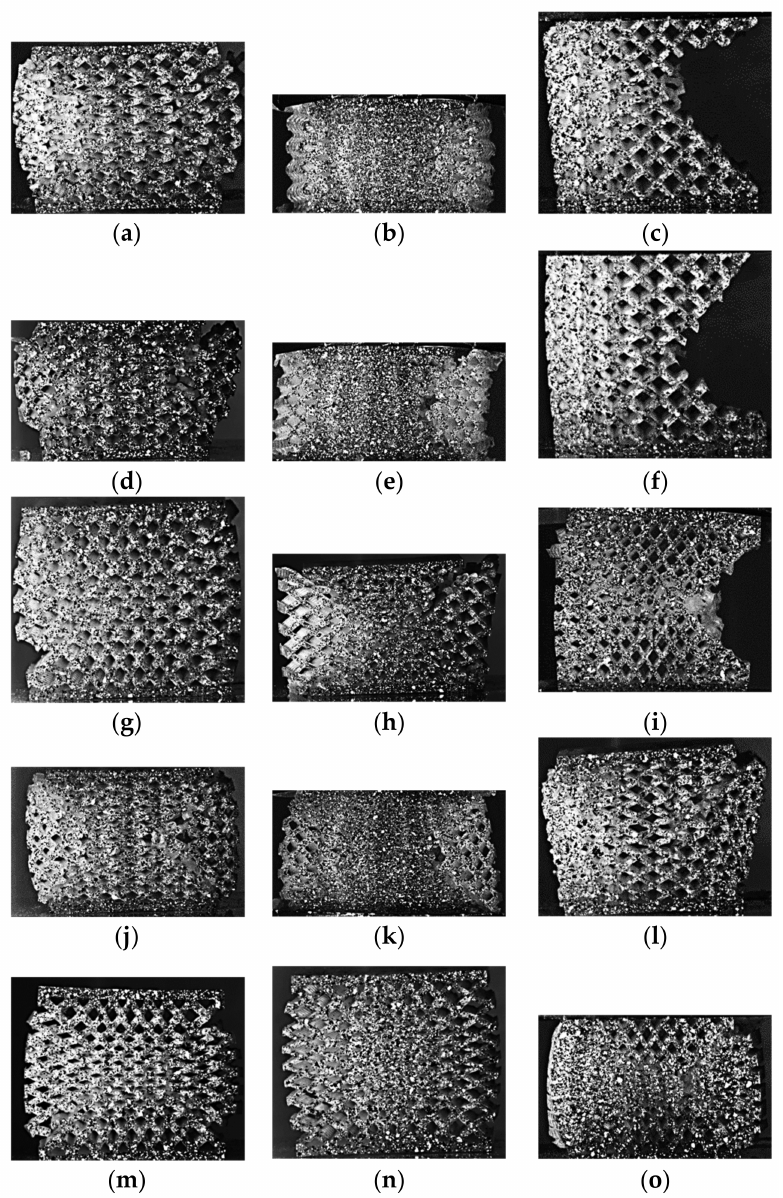
Figure 17. Deformation of the functionally graded lattices at the end of the compression test: ( a ) D1S1, ( b ) D2S1, ( c ) D3S1, ( d ) D1S2, ( e ) D2S2, ( f ) D3S2, ( g ) D1S3, ( h ) D2S3, ( i ) D3S3, ( j ) D1S4, ( k ) D2S4, ( l ) D3S4, ( m ) D1S5, ( n ) D2S5, and ( o )